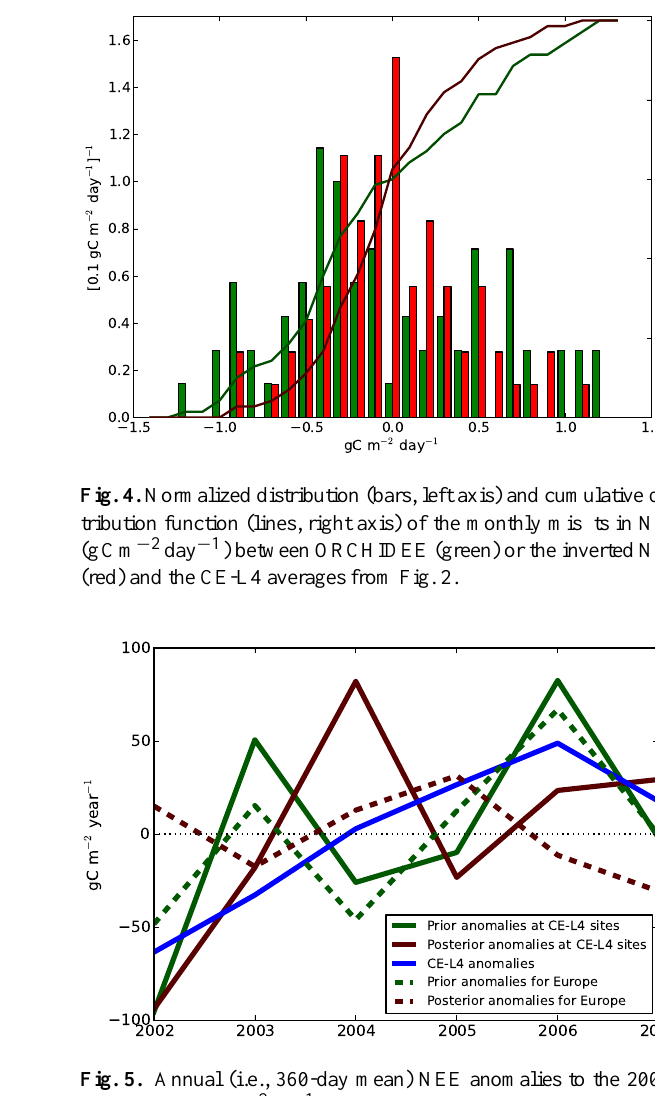
Fig. 3. Temporal evolution of monthly (i.e. 30-day mean) NEE ( g C m over the whole European domain of CHIMERE. Green: ORCHIDEE; red: inverted fluxes; shaded areas: NEE ± standard deviation of the uncertainty in NEE. Dotted lines: NEE ± standard deviation of the variations of NEE for a given month from 2002 to 2007.